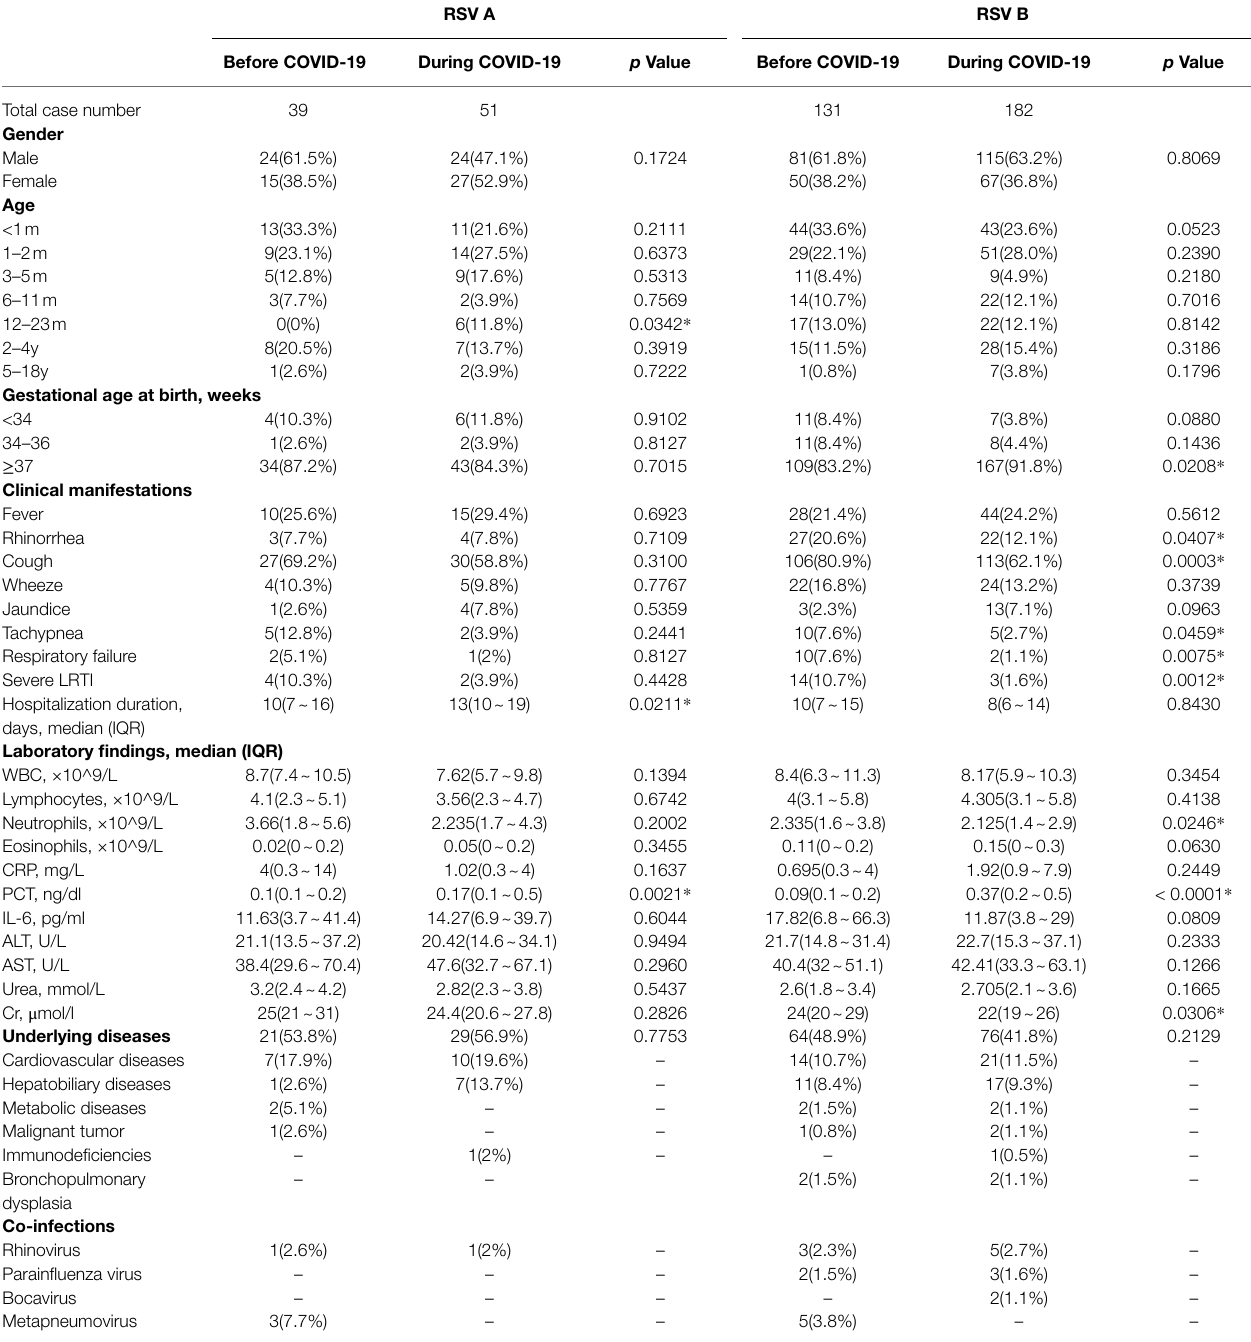
TABLE 2 | Demographic and clinical features of RSV A- or RSV B-positive patients before and during